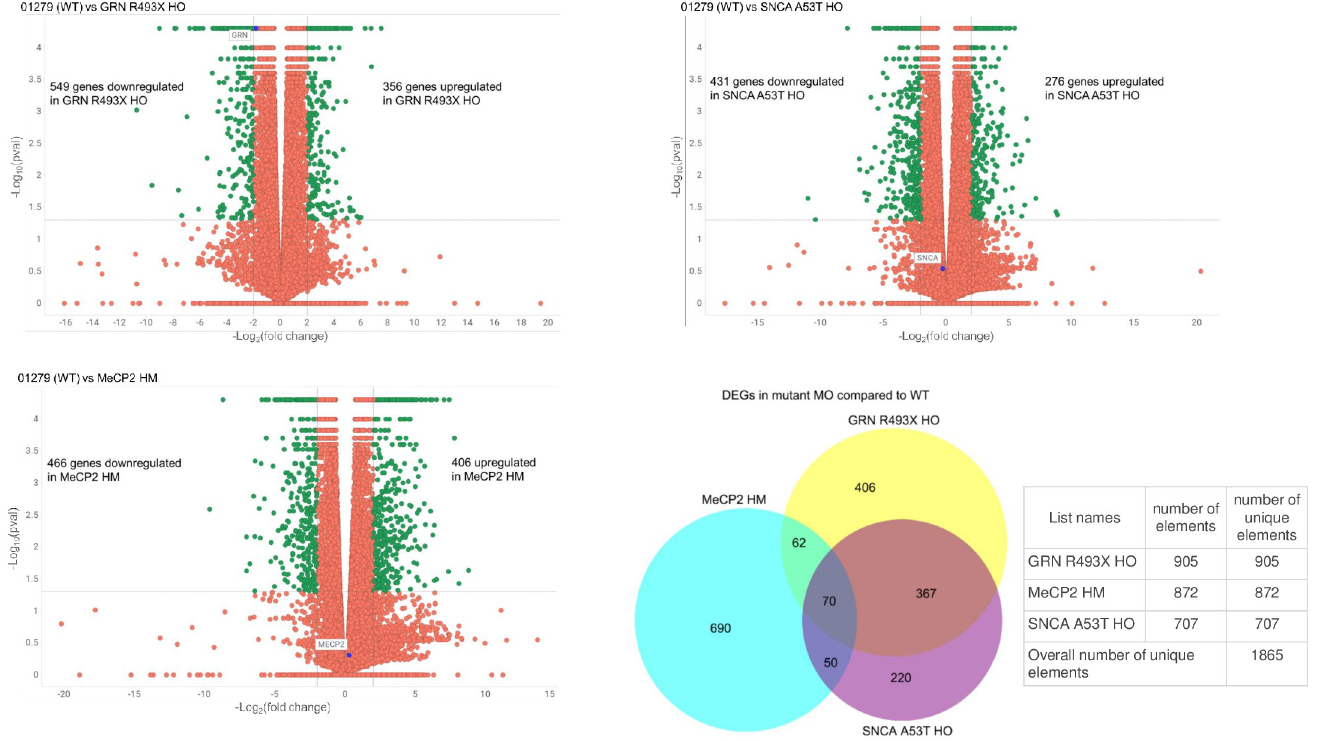
Fig 8. Differentially Expressed Genes (DEGs) of isogenic iPSC derived macrophages. Volcano plots of statistically significant differentially expressed genes at corrected P � 0.05 identified from the RNA-Seq analysis of SNCA A53T macrophage (A), GRN R493X macrophage (B), and MECP2 HM macrophage (C) relative to 01279 parental macrophage. The gene of interest expression is highlighted by a blue circle. Green circles represent statistically significant genes with an absolute fold change � 2. (D) Venn diagram of statistically significant DEGs of isogenic iPSC derived macrophages.